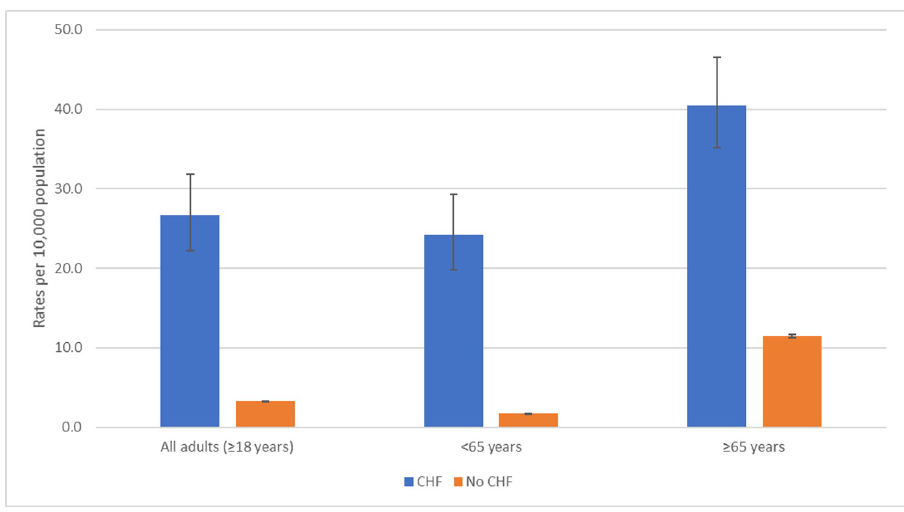
Fig 1. Adjusted rates a (per 10,000 population) of RSV-associated hospitalization by congestive heart failure (CHF) status, RSV-NET, 2015–2017 (N = 2042). a Adjusted for age and the under-detection of